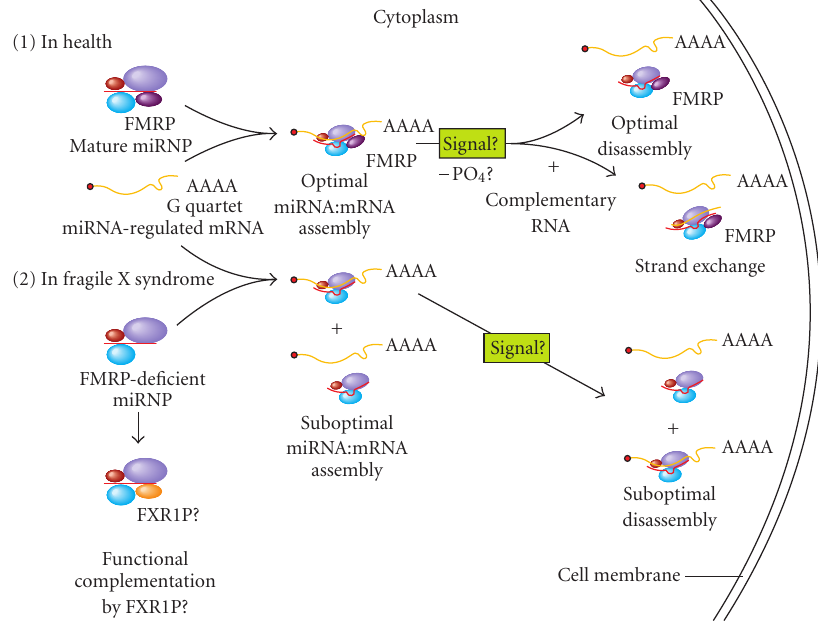
Figure 2: Proposed roles and functional regulation of FMRP in miRNA-guided RNA silencing. (1) mRNA targeting by mature miRNPs may involve the concerted assembly of the miRNAs to their binding sites with the recognition of G quartet structures in specific mRNAs by FMRP (in purple). Acting within miRNPs, FMRP may play a key role by relieving translational repression through disassembly of the miRNA:mRNA complexes. mRNAs repressed by miRNPs could thus be reutilized and translated into proteins. This process may be triggered by a cellular signal, possibly a dephosphorylation event. A variant of that phenomenon would have a complementary RNA, like the miRNA ∗ , involved in a strand exchange reaction making the mRNA available for translation, while recycling the miRNP into a duplex miRNA- containing RNP. (2) In the absence of FMRP, miRNA assembly on target mRNAs may be suboptimal. Moreover, FMRP-deficient miRNPs may be less responsive to signal-induced miRNA:mRNA disassembly, resulting in a suboptimal dissociation from the target mRNAs. In certain tissues where it is expressed, the FXR1P paralog (in orange) may functionally complement, and possibly compensate for, the absence or loss of FMRP